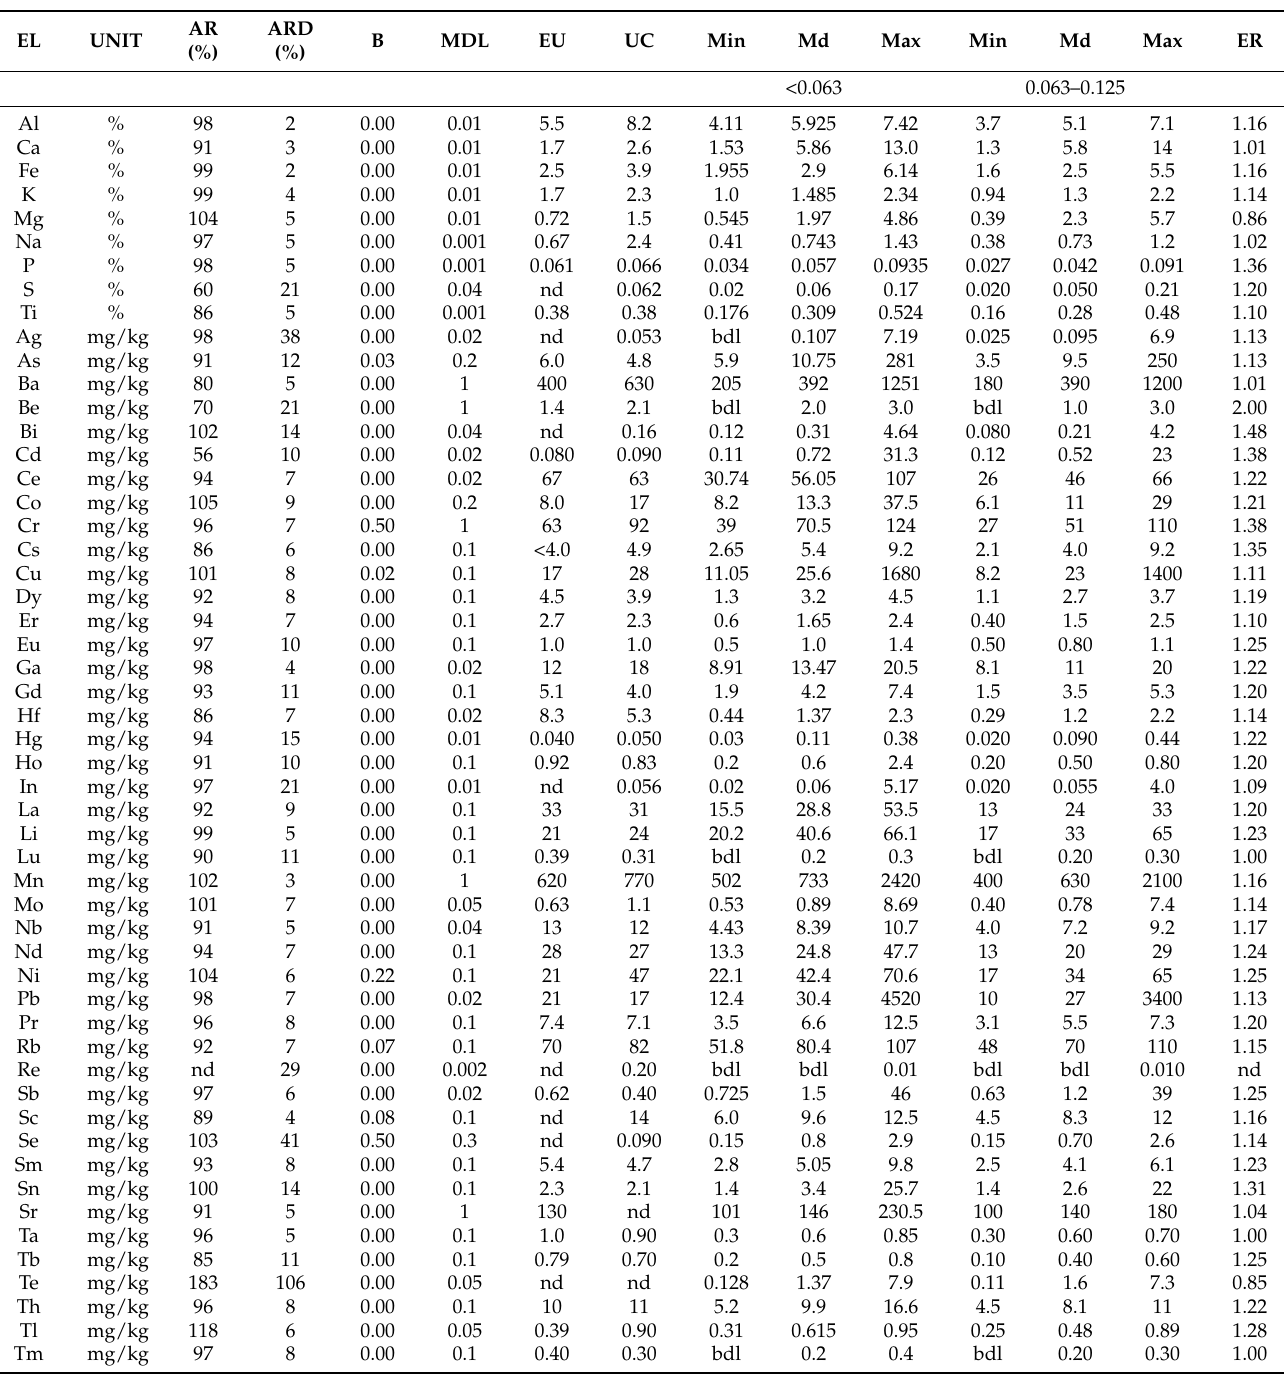
Table 1. Descriptive statistics of elemental levels in stream and alluvial sediments (53 samples) in the studied area and their comparison with European average values for stream sediments [31] and upper continental crust [32] and the enrichment ratio between median values in the smaller fraction, compared to coarser